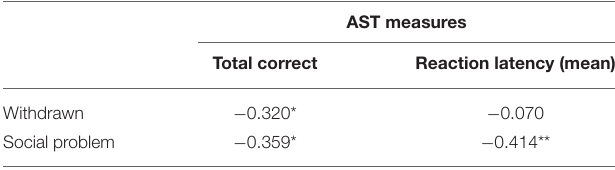
TABLE 6 | Correlation coefficients of the AST measures with the CBCL withdrawn and social problem subscale scores in the SCT group.